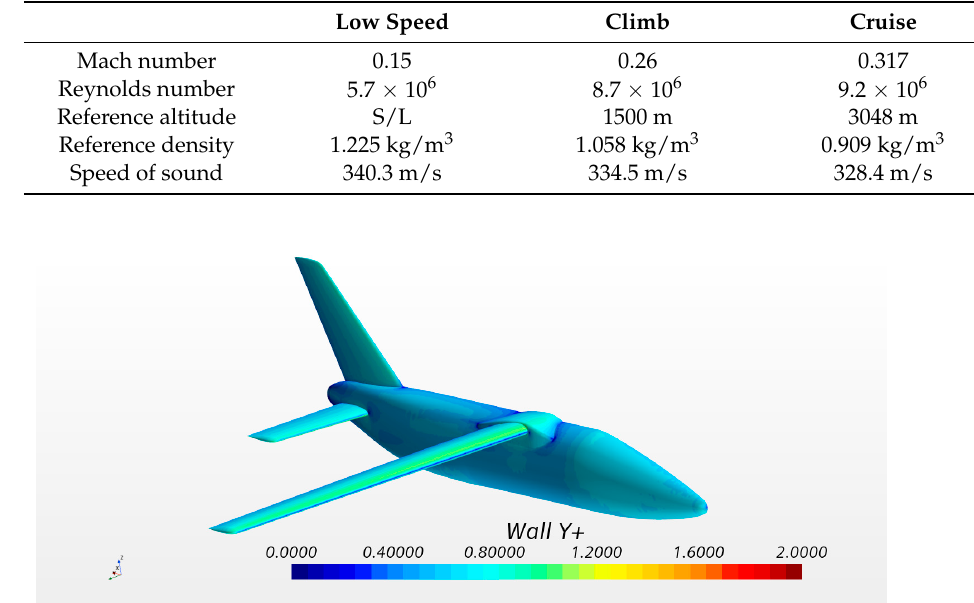
Table 3. Flight conditions.